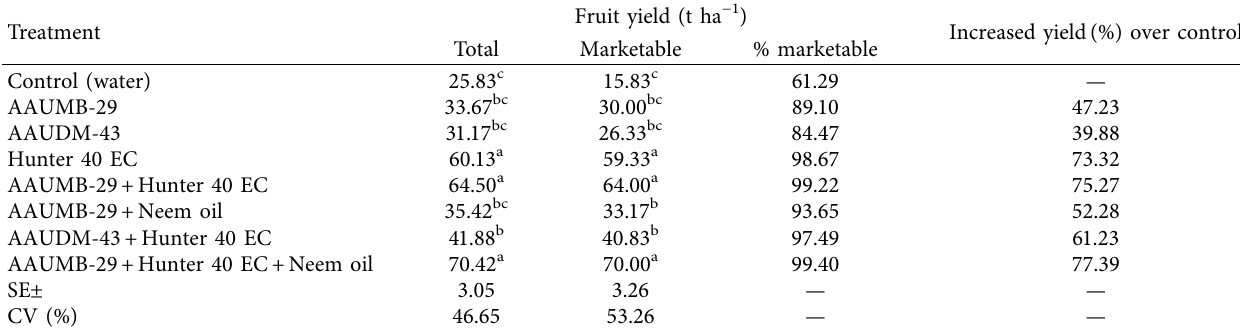
Fruit yield (t ha − 1